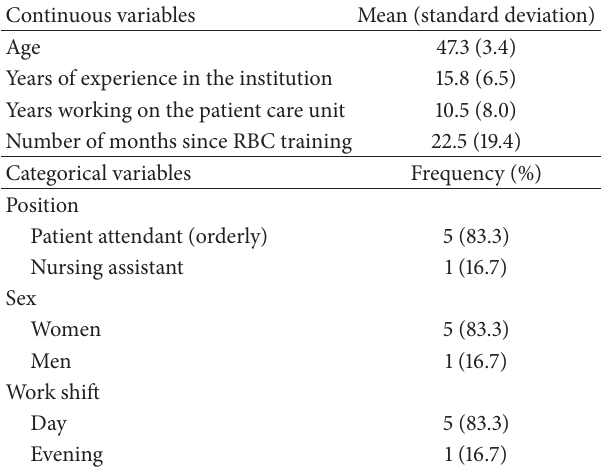
Table 2: Caregivers’ characteristics ( 𝑛 = 6